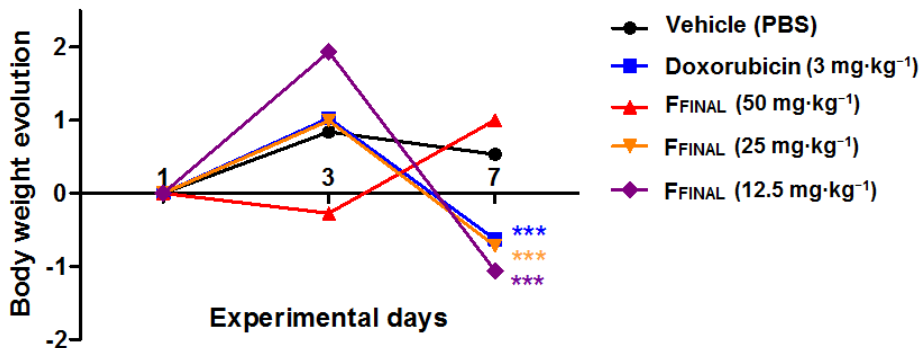
Figure 10. Animal bodyweight, variation during the Hollow fiber experiment—F FINAL fraction. Bodyweight variation during 7 days of treatment; results expressed as mean of each experimental group; Female Balb / c mice ( n = 5 animals / group); Treatments (orally every day): vehicle (PBS pH 7.0 + Tween 80, 10 mL · kg − 1 ), F FINAL (12.5, 25, and 50 mg · kg − 1 ); Treatments (i.p., every three days):